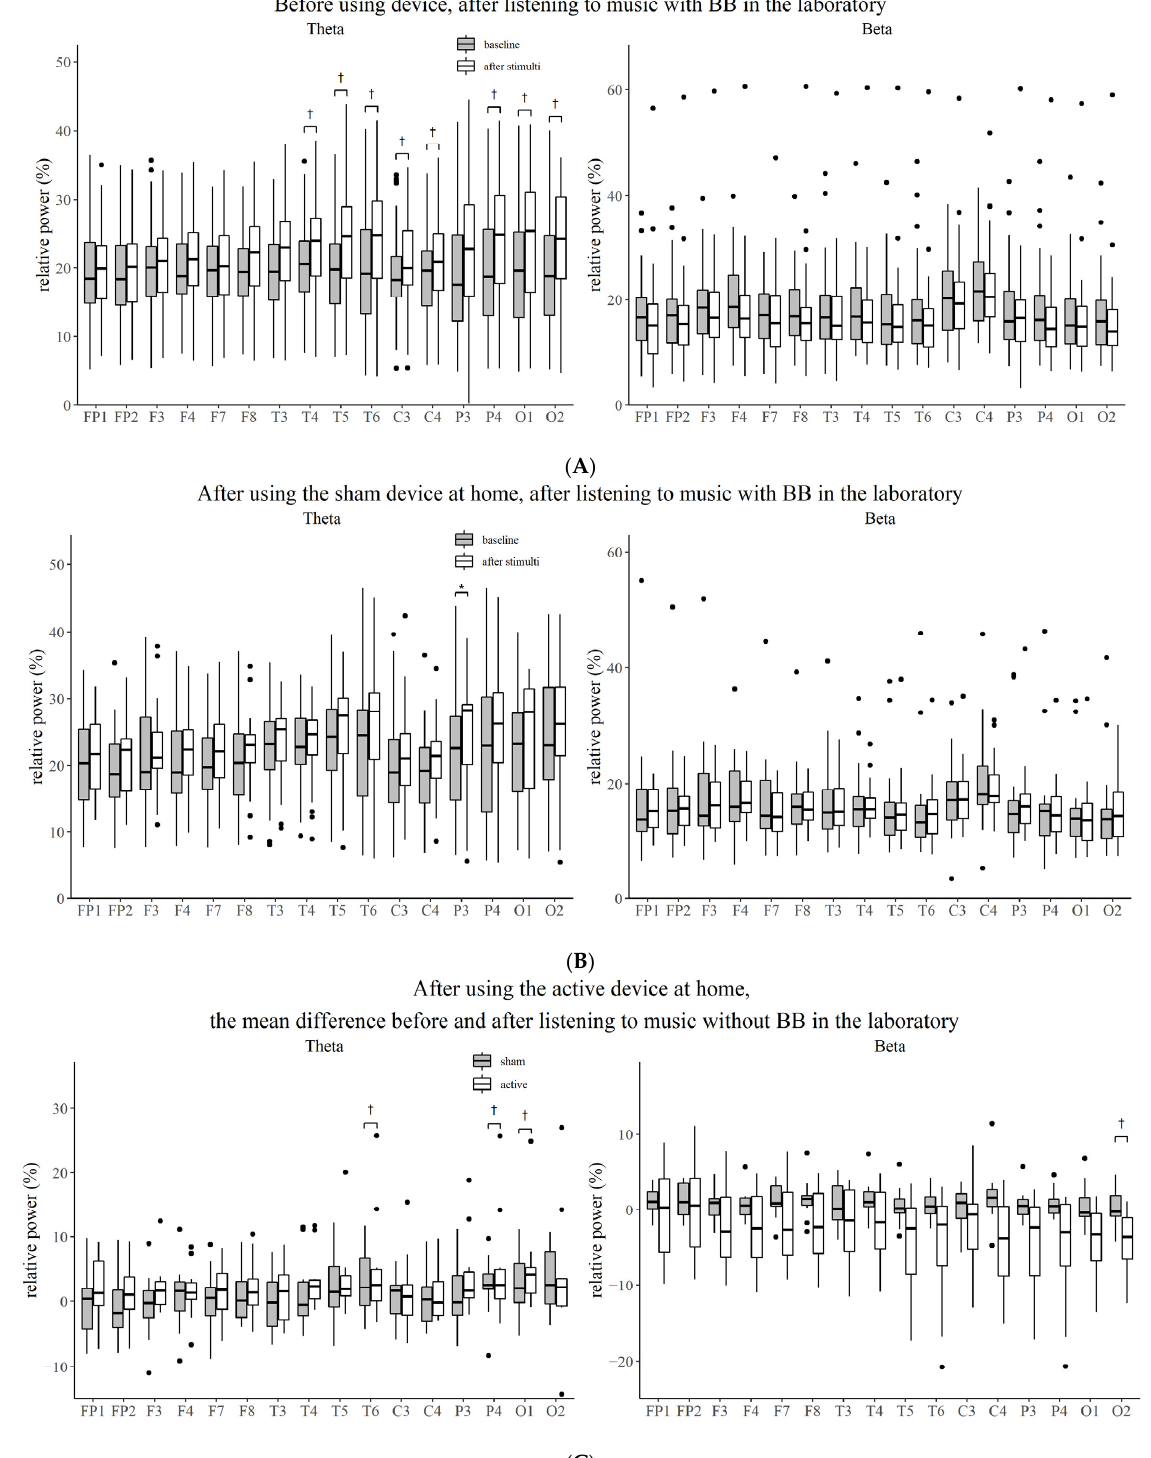
Figure 3. Comparison of the relative power between the baseline state and the state after stimulation for each electrode. ( A ) Before using device, after listening to music with BB in the laboratory. ( B ) After using the sham device at home, after listening to music with BB in the laboratory. ( C ) After using the active device at home, the mean difference before and after listening to music without BB in the laboratory. BB, binaural beat; *, Bonferroni corrected p -value < 0.05; †, p -value <